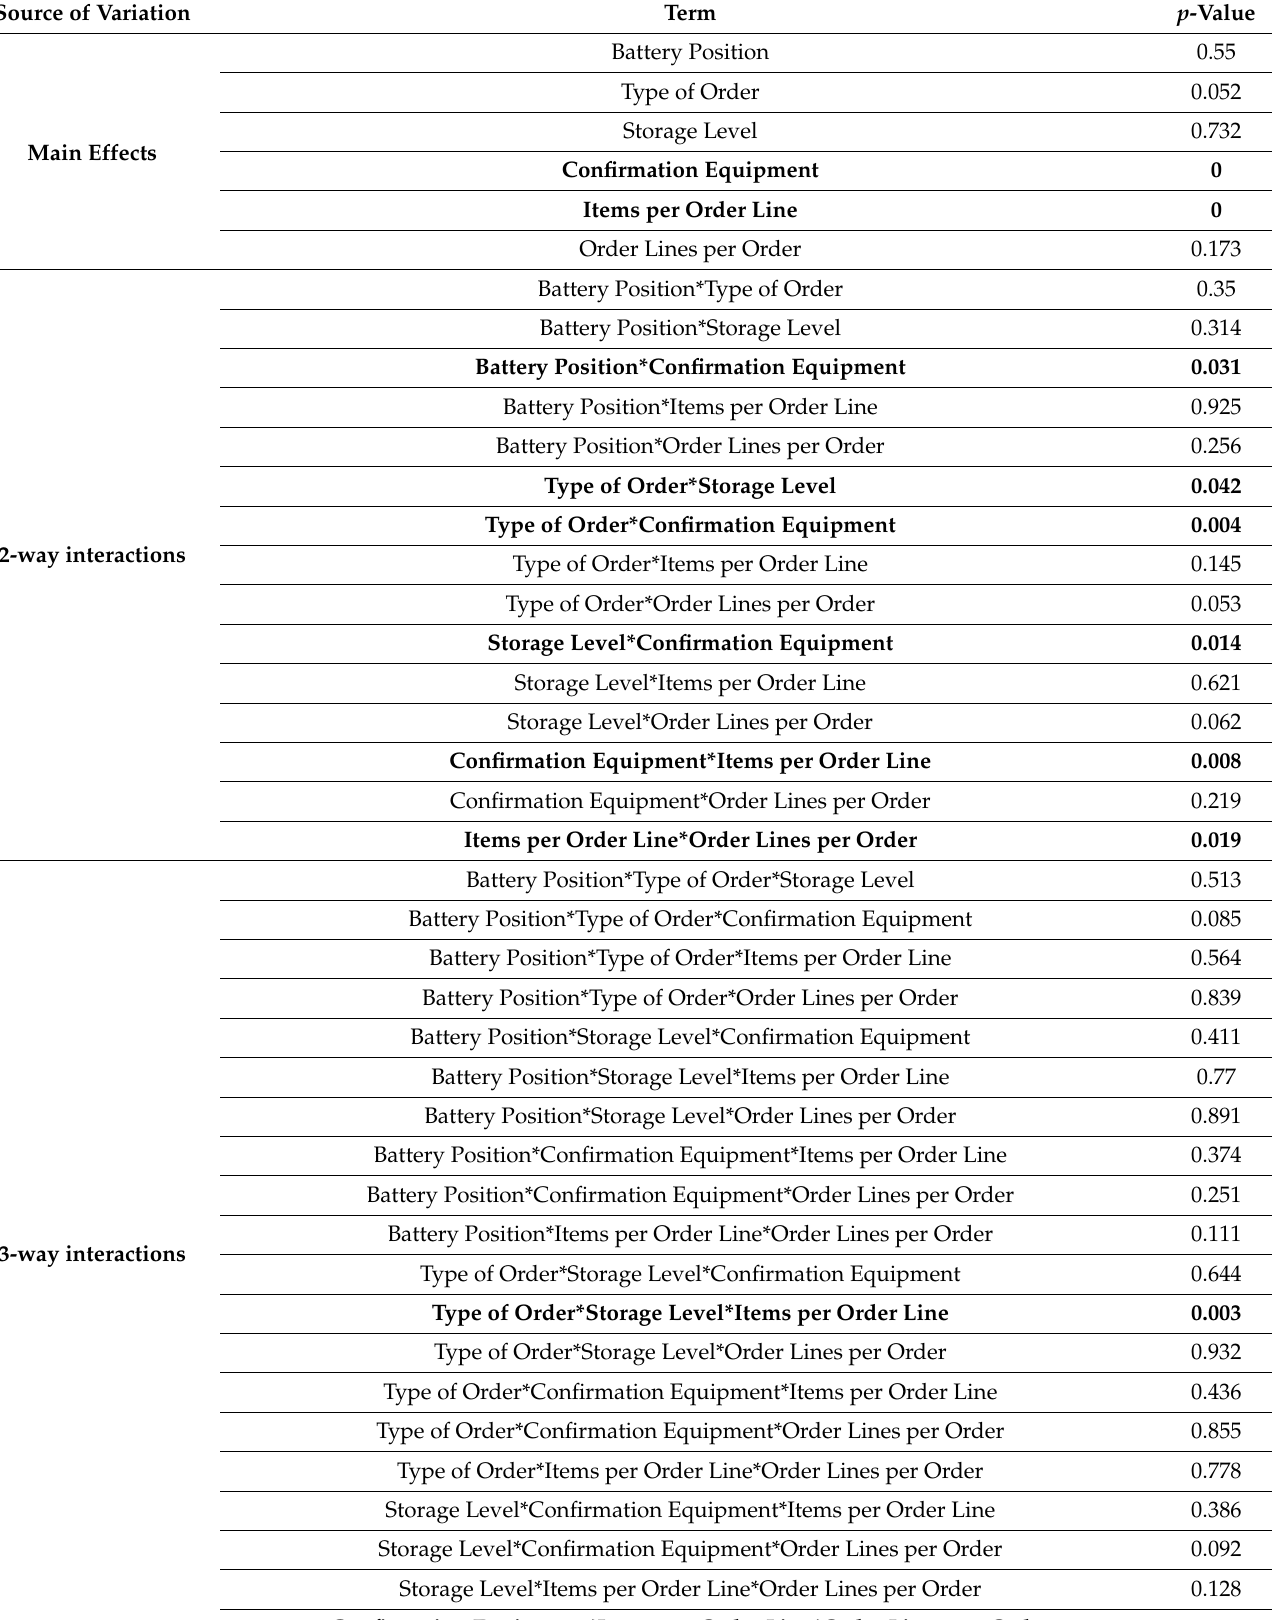
Table 6. Results of statistical analysis (estimated effects) on order-picking time (efficiency). The symbol * relates the main effects as far as their interactions are